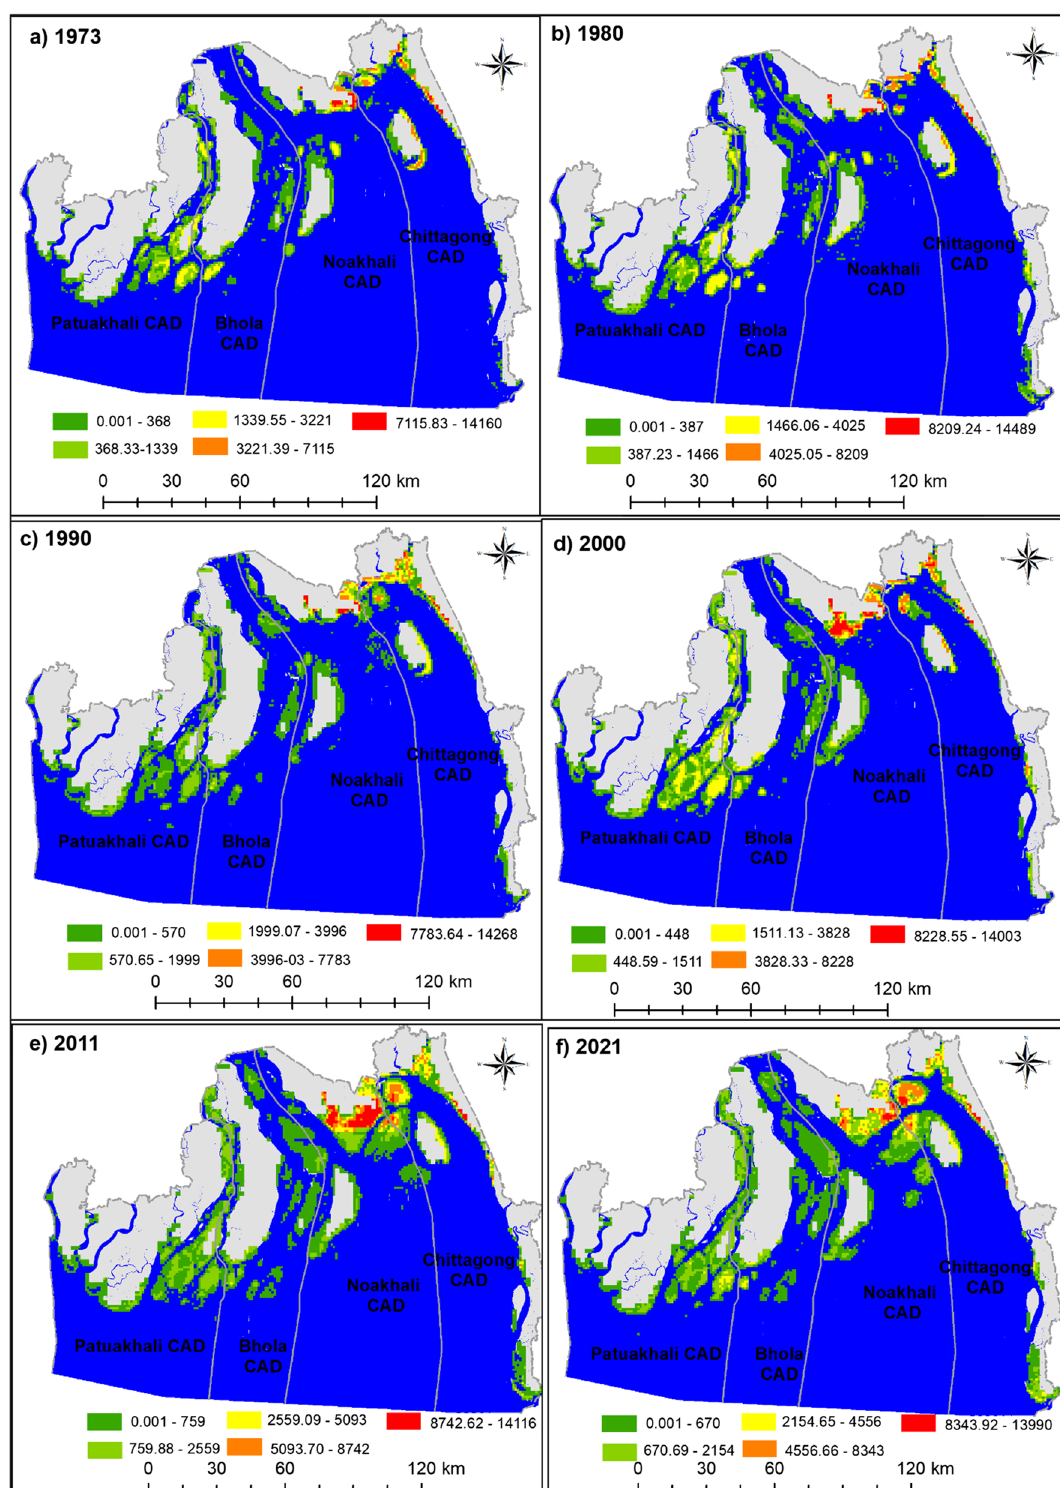
Fig. 11 Spatial distribution of land price (in USD) of the stable land (agricultural